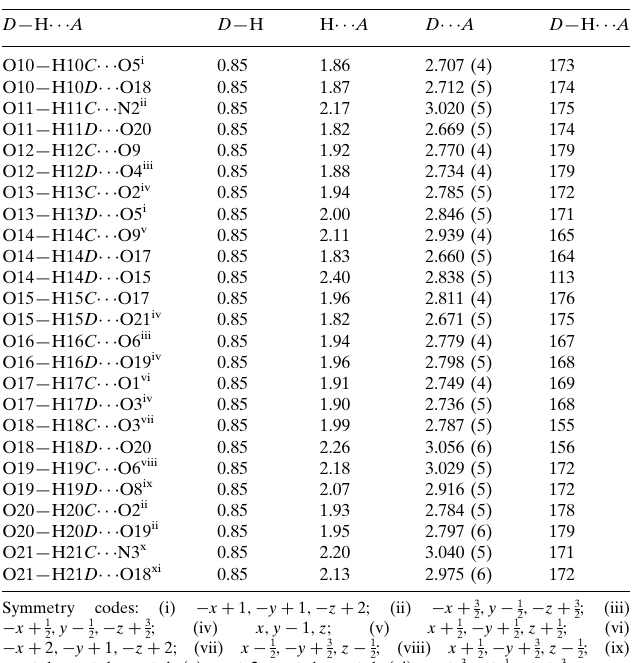
Hydrogen-bond geometry (A˚ , (cid:2)